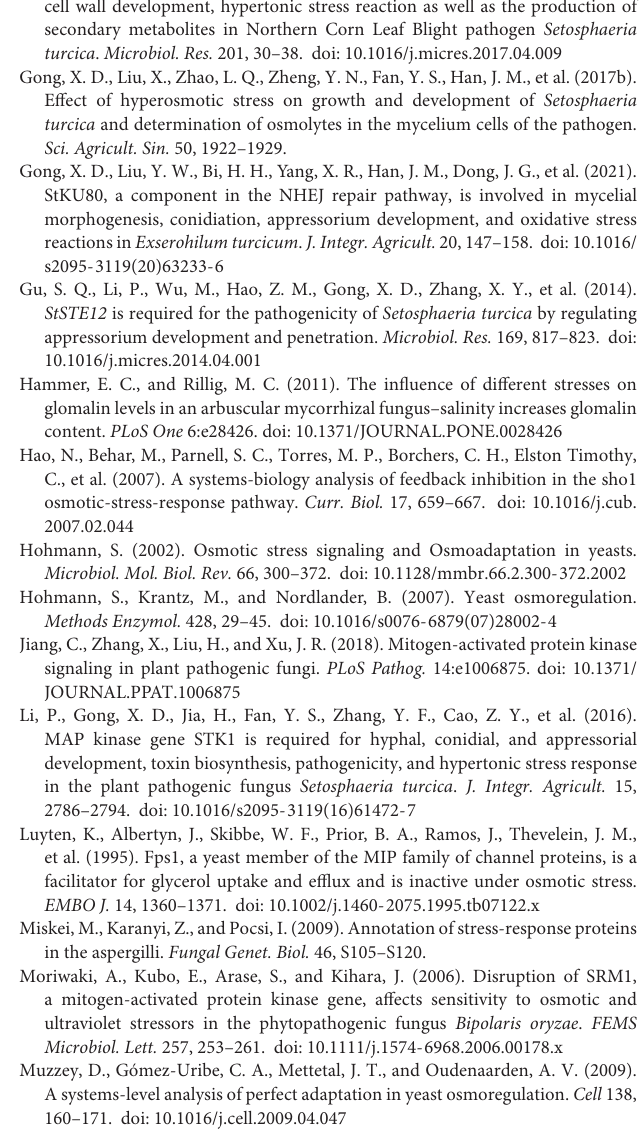
Supplementary Figure 1 | Morphology of conidia culture under the three osmotic conditions (0.4 M NaCl, 0.4 M KCl, and 0.6 M sorbitol) and control (PDA) conditions. Supplementary Figure 2 | Observation of appressorium development of S. turcica grown for 3 h in 1.1 M NaCl, 1.1 M KCl, and 1.3 M sorbitol media. ap: appressorium; h: invading hyphae. Supplementary Figure 3 | The phenotype of StFPS1 knockout mutants. Supplementary Table 1 | The primers used in this